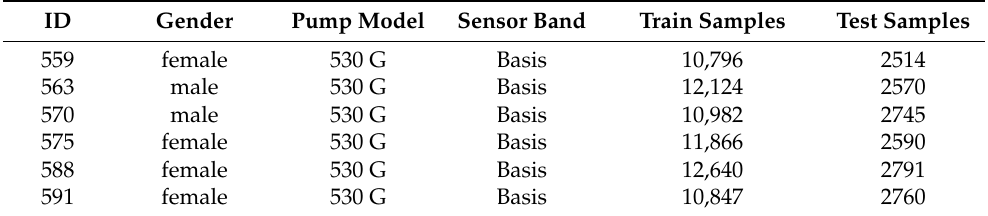
Figure 2. Feature visualization using data of T1DM patient ID 570. Table 1. Ohio T1DM dataset contributor details.